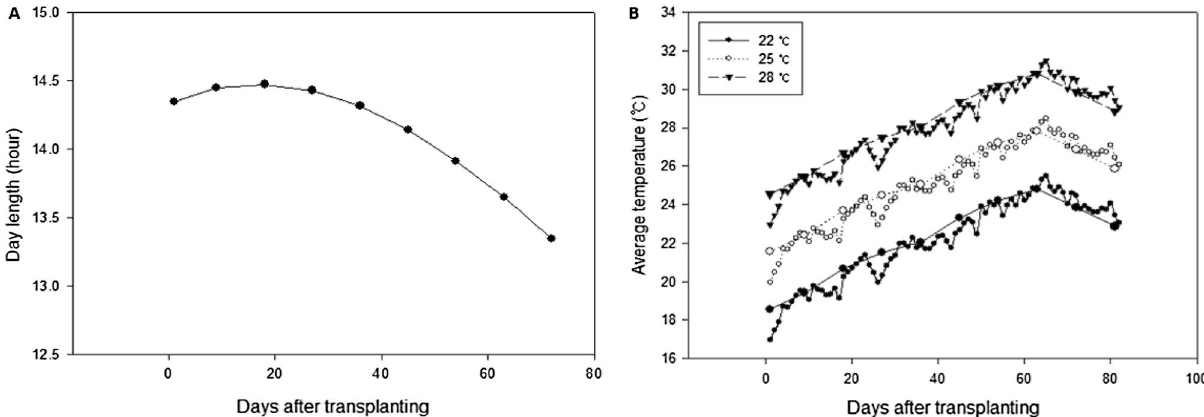
Figure 1. Changes in day length ( A ) and average temperature ( B ) during the growing period of rice from transplanting to